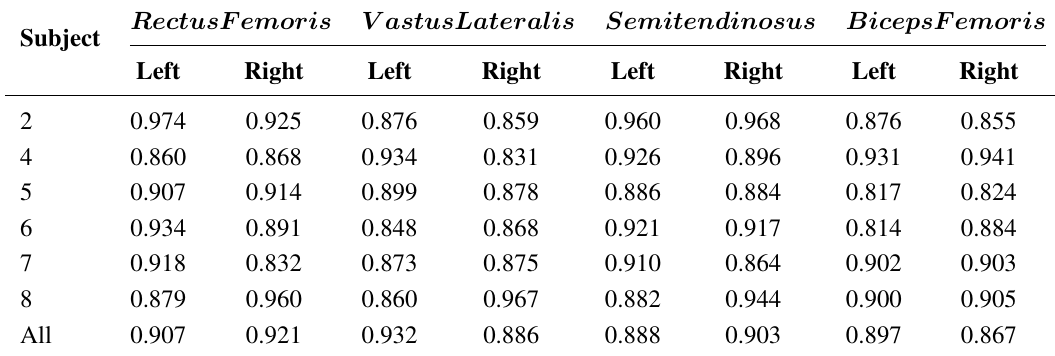
Table 4. The coefficient of determination R 2 for some subject-specific, as well as general random forest regression models for predicting oxygen